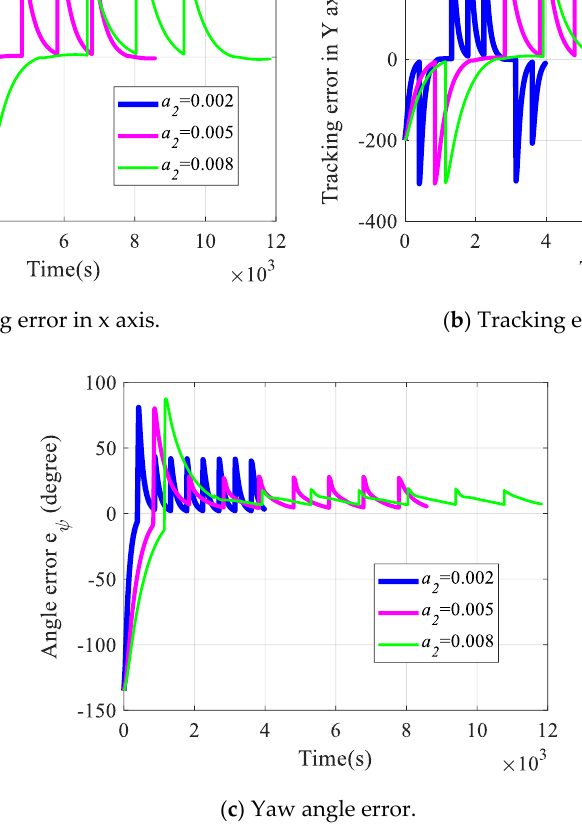
Figure 15. Tracking errors of controlled AUSV with respect to di ff erent control gains a 2